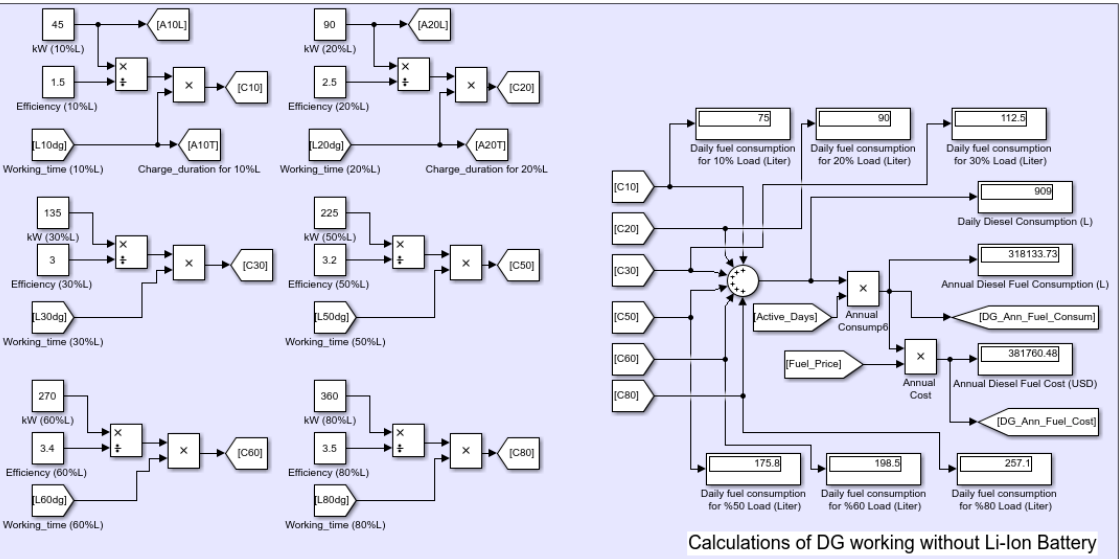
Figure 6. Calculation block for DG working without Li-ion battery.